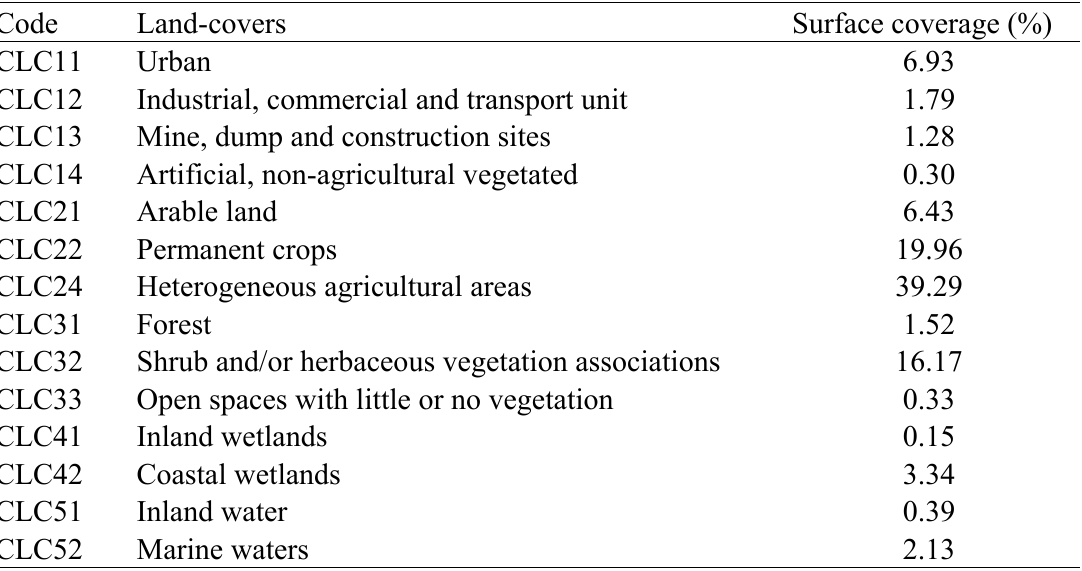
Table 1. CORINE land-cover 2000 level II land-cover classes of the study area, and their relative